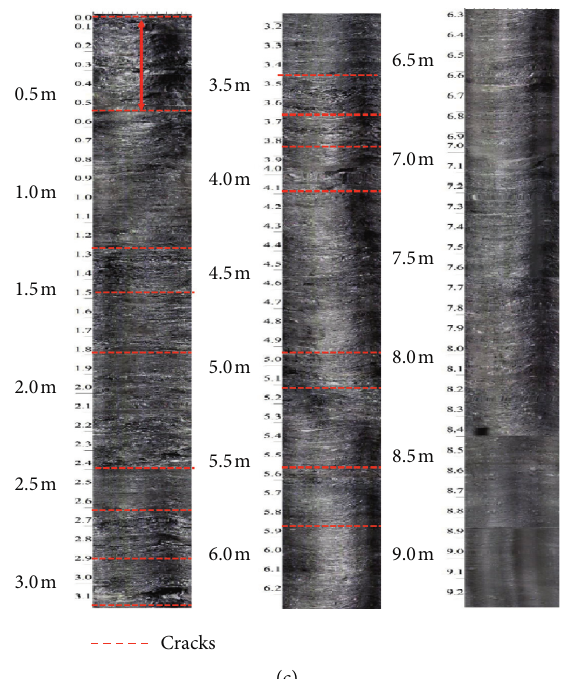
Figure 19: The typical borehole fracture images of surrounding rock in different depths. (a) The junction of the roof and the left sidewall. (b) The middle of roof. (c) The sidewall of roadway surrounding rock.